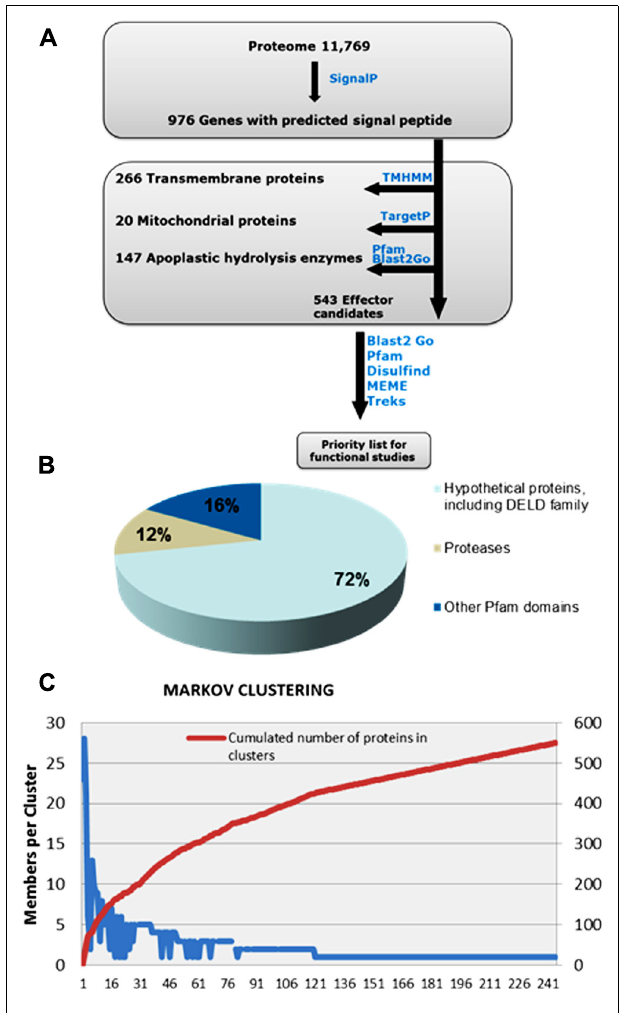
FIGURE 2 | Overview of the computational pipeline used to mine the list of effector candidates in the secretome of P. indica . (A) P. indica secretome, consisting of 972 proteins, was predicted using SignalP. Proteins containing transmembrane domains and proteins with mitochondrial signals were removed usingTMHMM andTargetP, respectively. Apoplastic hydrolysis enzymes, such as chitinases and glucanases, were removed based on their function and not on their size, using Pfam and Blast2Go.The remaining total number of 543 proteins are considered effector candidates. Notably, 72% of effector candidates are novel sequences of unknown function (B) MCL analysis (C) has resulted in a high number of singletons and has shown no evidence for gene